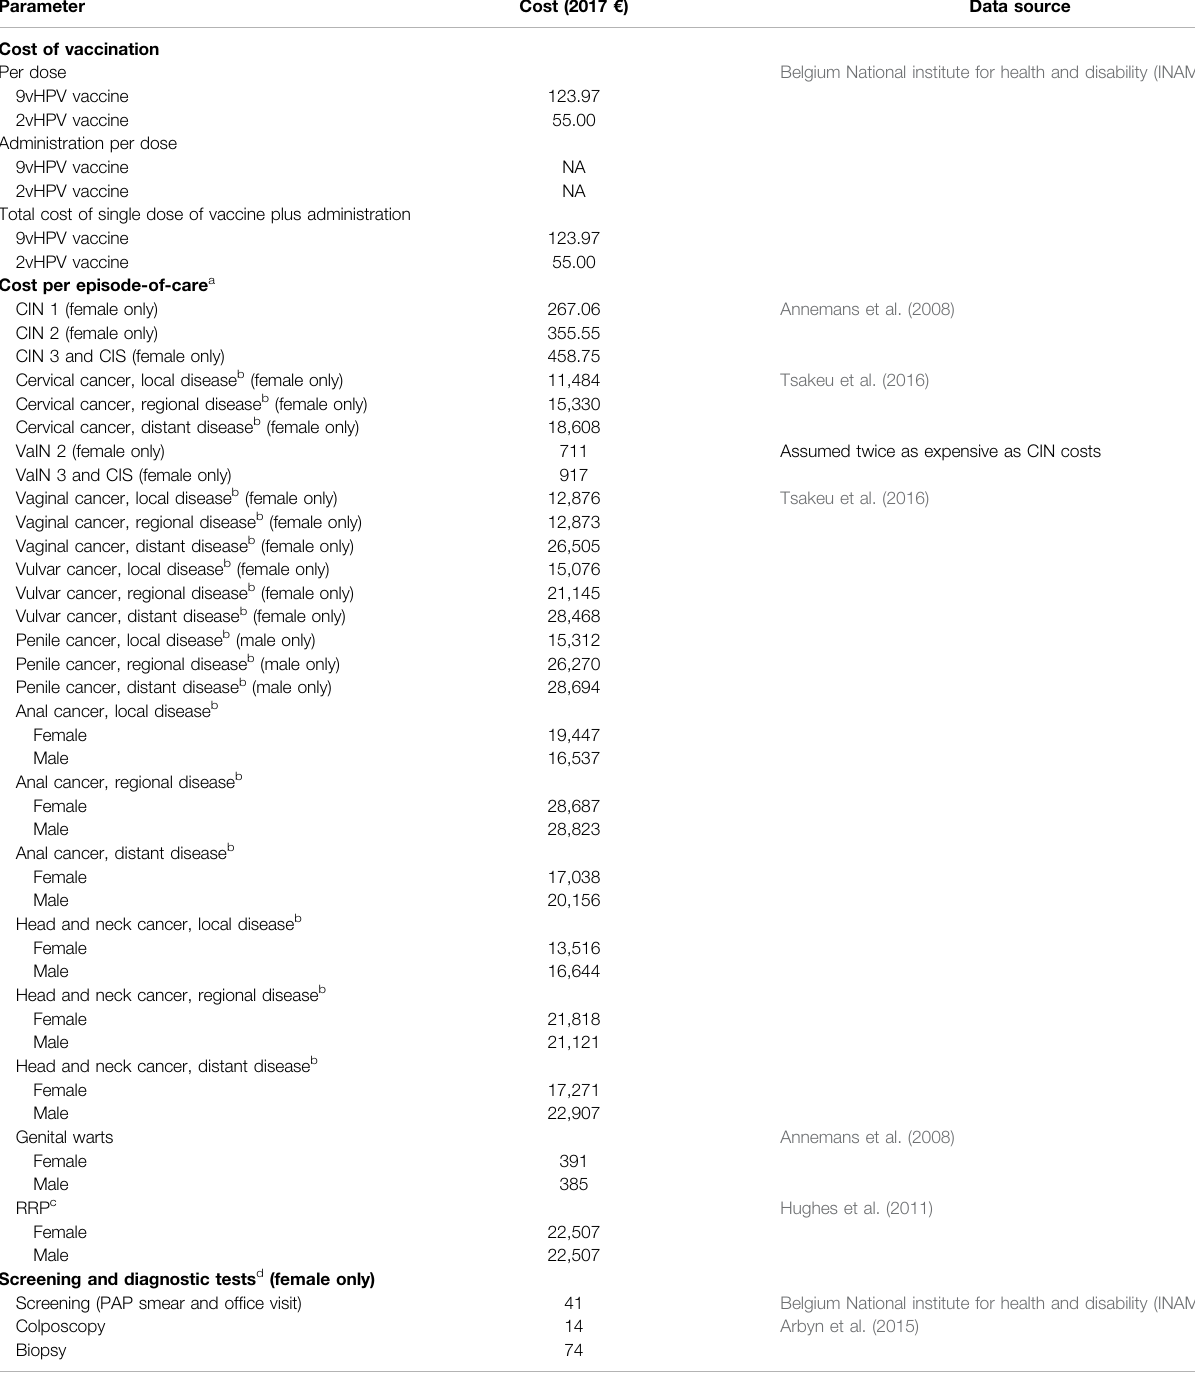
TABLE 3 | Summary table on cost parameters for HPV-related diseases (third-party payer perspective; 2017 €